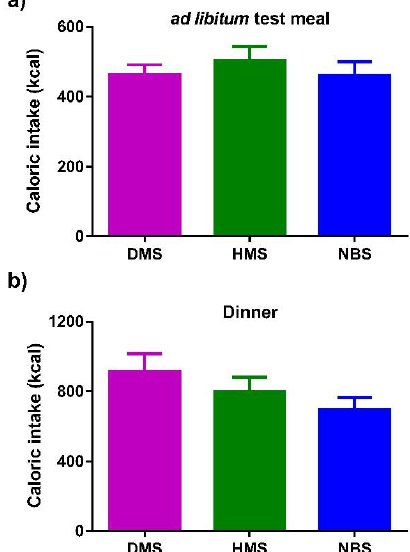
Figure 5. Caloric intake during the (a) ad libitum test meal and (b) dinner. Data for dinner were obtained from food records. Data are expressed as mean ± SEM ( n = 14). Comparisons are based on one-way ANOVA with Tukey post-hoc